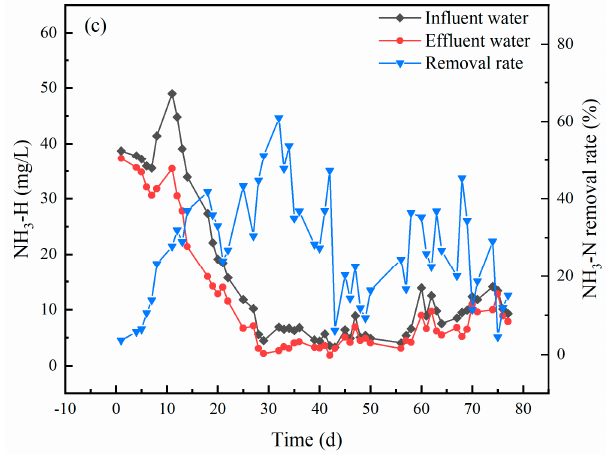
Figure 5. Effect of running time on processing efficiency of the two-stage AO unit: ( a ) COD, ( b ) TN, ( c ) NH 3 -N.